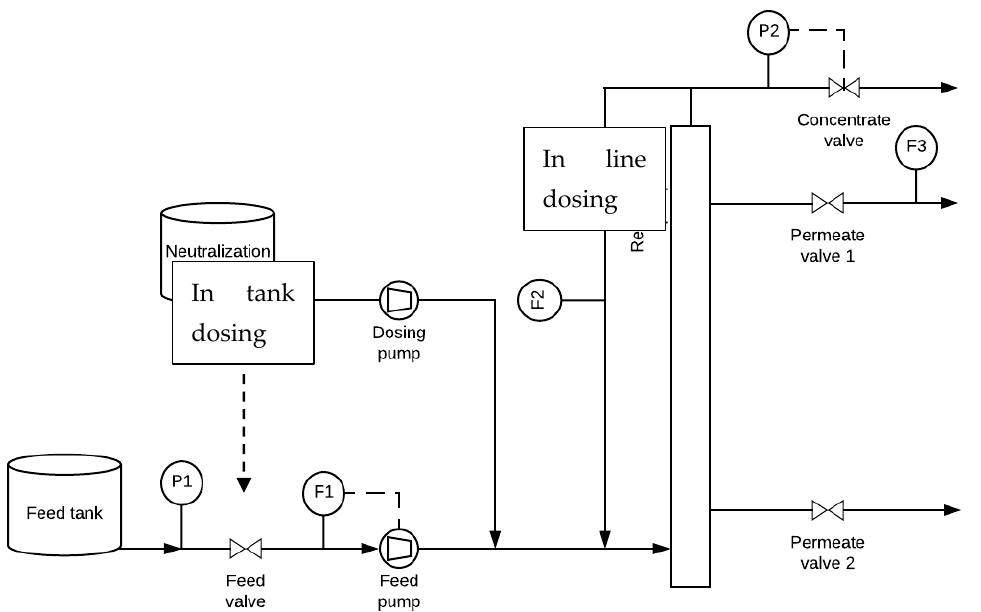
Figure 1. Schematic representation of the ceramic micro-filtration (CMF) setup. F1—feed flow meter (0–300 L h − 1 ± 1 L h − 1 ). F2—recycle flow meter (0–1000 L h − 1 ). F3—permeate flow meter (0–30 L h − 1 ). P1: pressure meter (0–20 ± 0.1 bar). P2—pressure meter (0–20 ± 0.1 bar). Table 2. Ceramic micro-filtration (CMF) membrane specification (Inopor